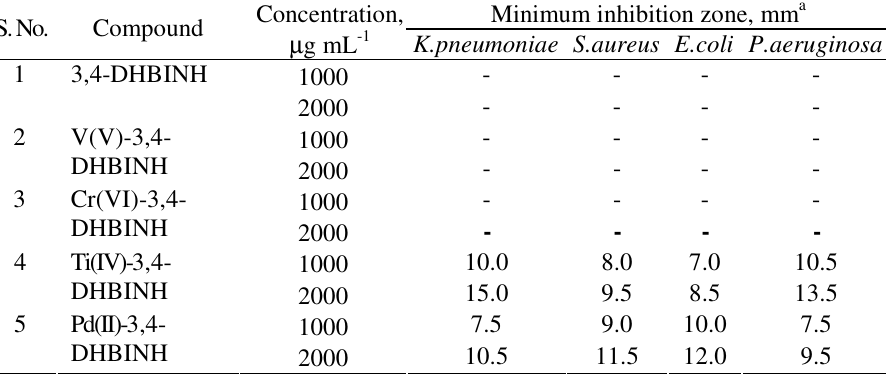
Minimum inhibition zone, mm a